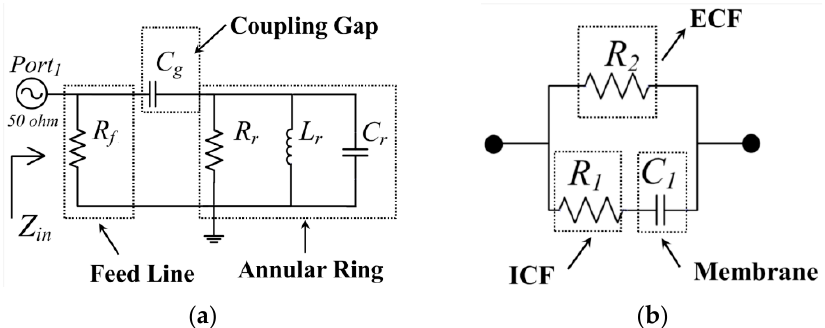
Figure 4. Equivalent RLC circuit of ( a ) Capacitively coupled ring resonator; ( b ) Fricke model representing the biological tissue.